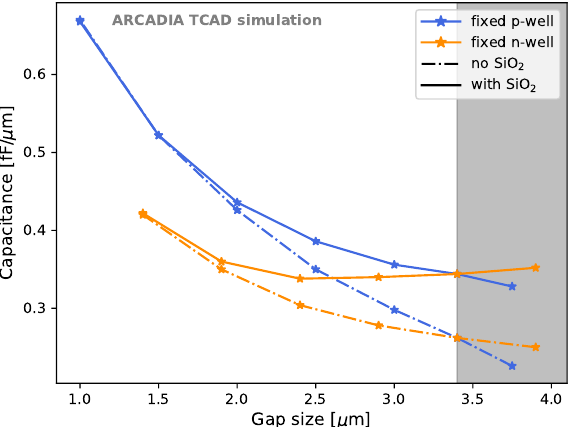
Figure 16. C sens as a function of the gap size for different sensor layout configuration. The vertical grey band is the forbidden region due to fabrication constraints; its leftmost limit is still permitted.